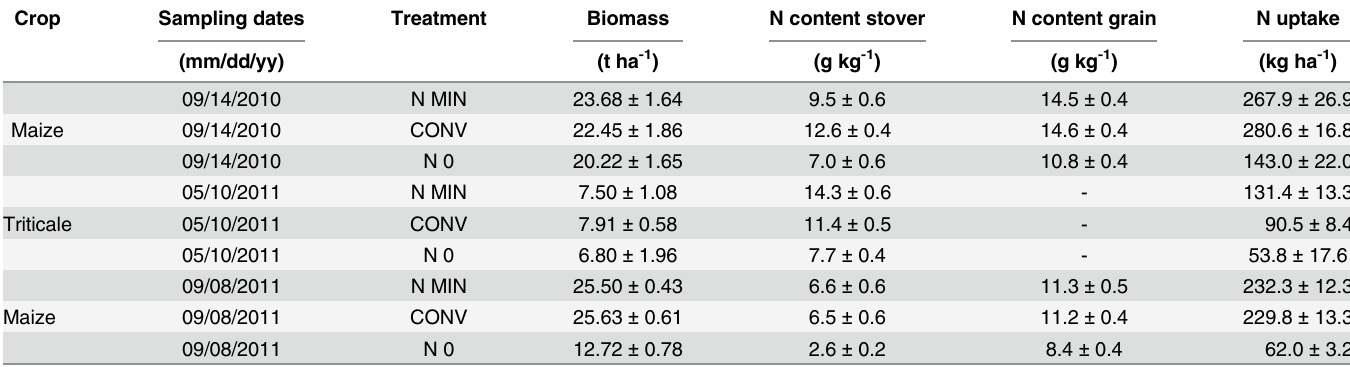
Table 7. Means and standard errors of biomass, N content and N uptake at the harvest dates of maize and triticale crops (n = 3). Sampling dates cor- respond to the harvest of maize (09/14/2010), triticale (05/10/2011) and maize (09/08/2011). Dates are reported as mm/dd/yy. Crop Sampling dates